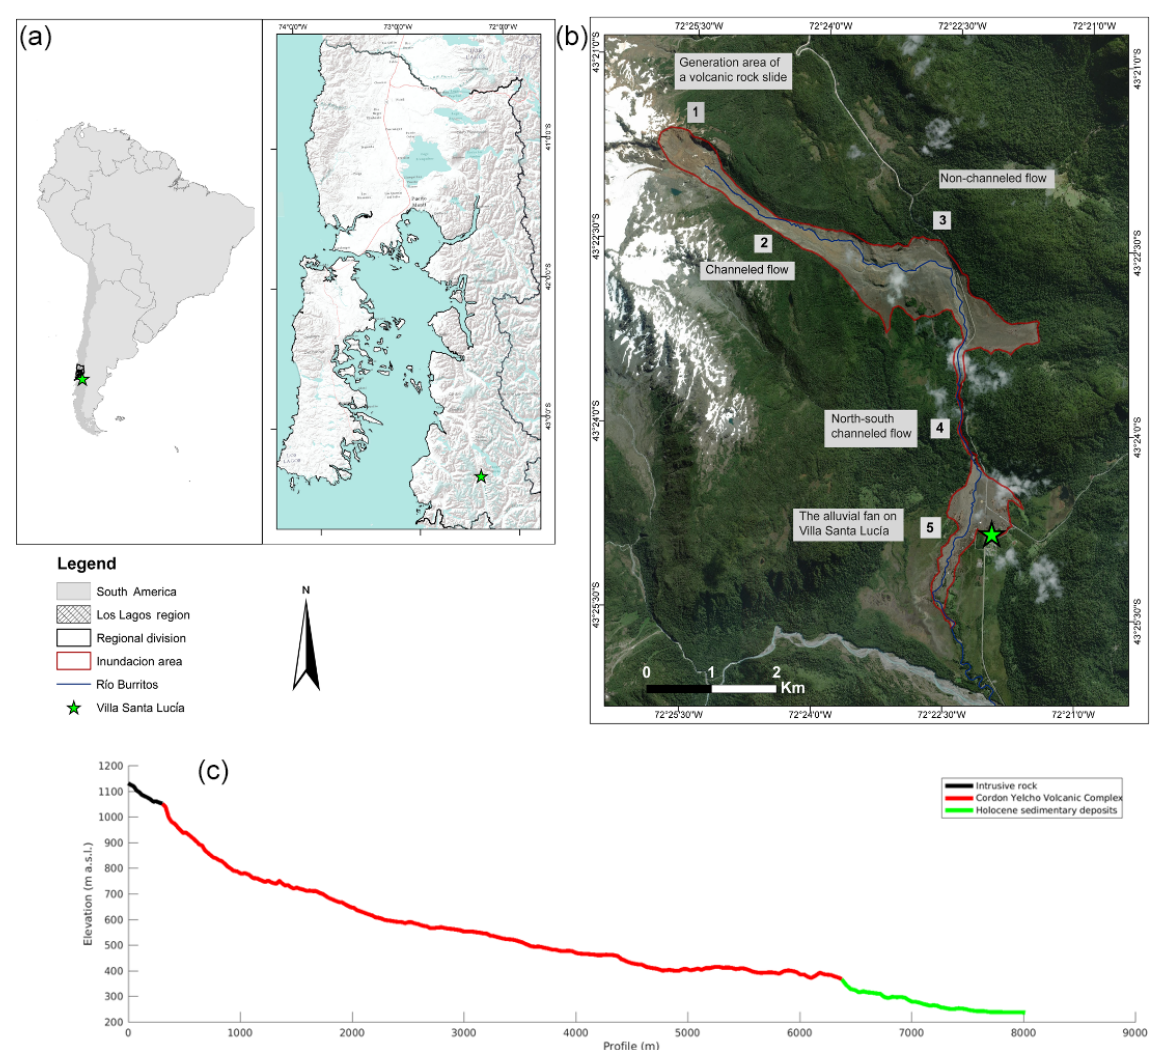
Figure 1. a Study area and extension mudflow (South America and Los Lagos region layer from https://tapiquen-sig.jimdo.com (last access: 19 November 2019), b Río Burritos blue line layer from http://datos.cedeus.cl/ (last access: 19 November 2019, background © ESRI). c Elevation profile and geological formation along the mudflow